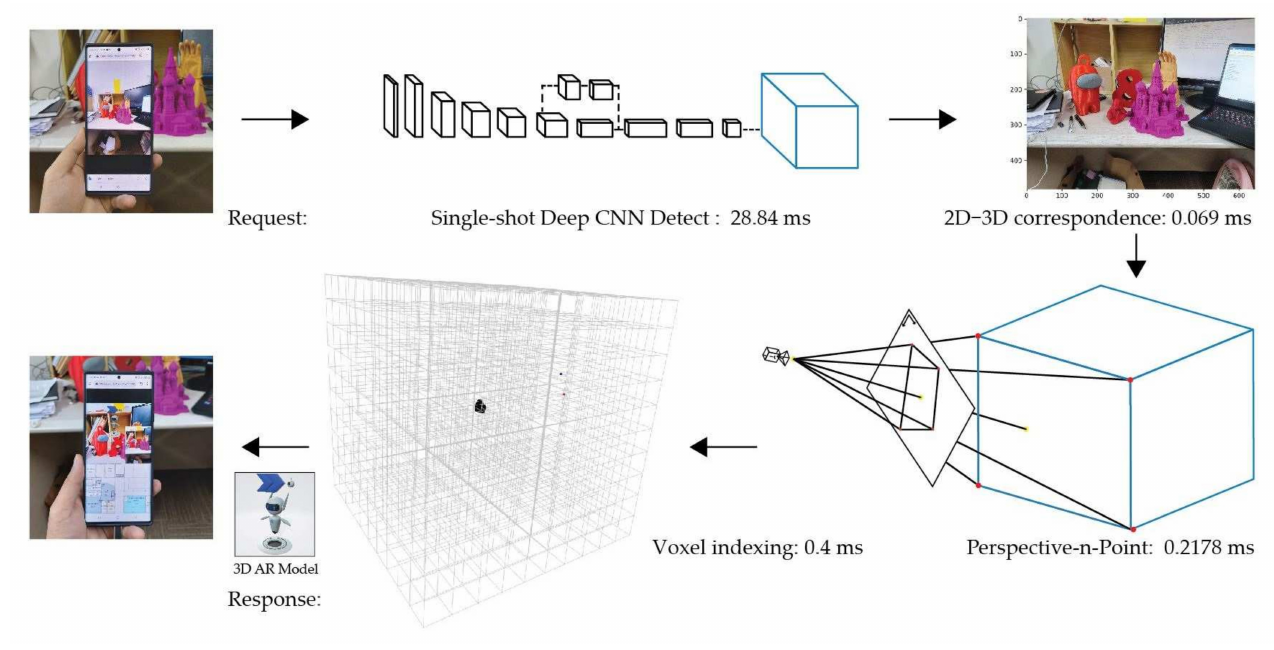
Figure 5. Runtime analysis and comparison of method performing single object pose estimation. LineMOD dataset is used. Table 2. VPS speed measured by the proposed method